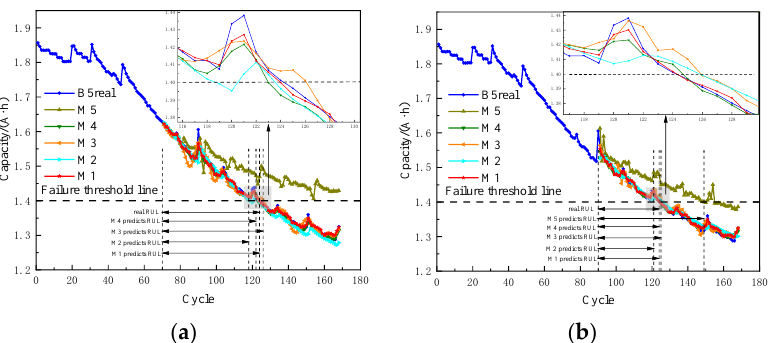
Table 3. Description of the methods.